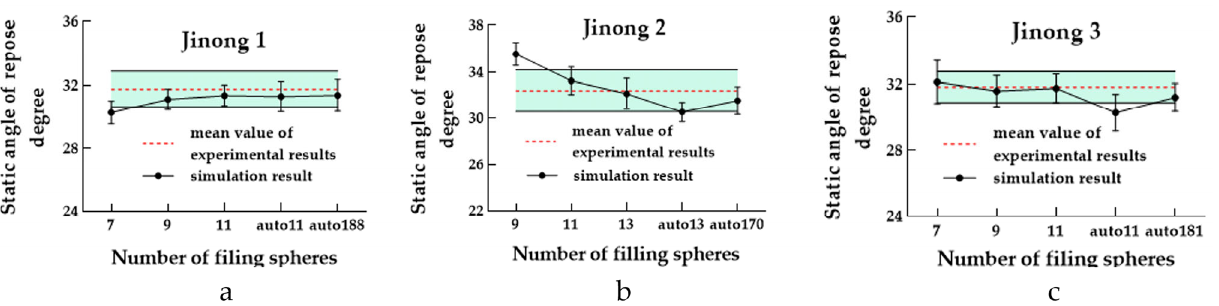
Figure 16. Simulation results of the piling test.